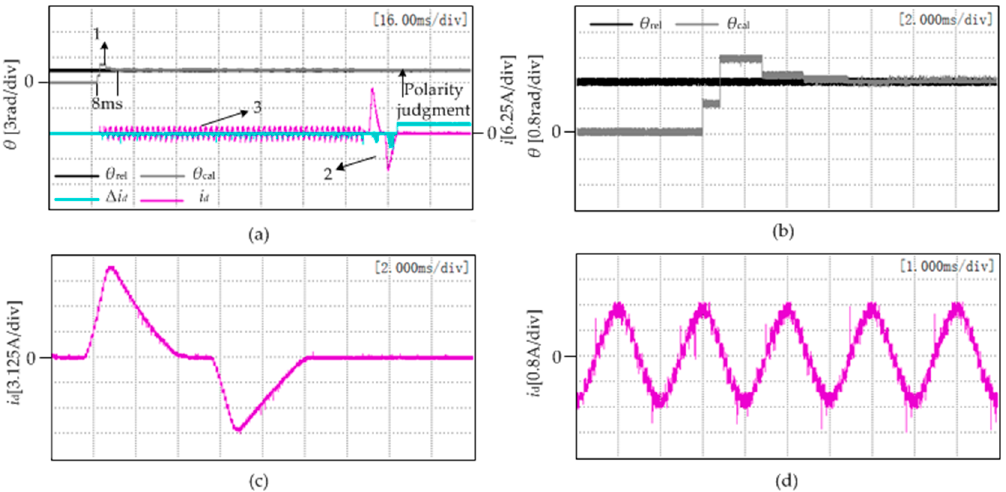
Figure 12. When θ = 88.7 ◦ : ( a ) angle comparison and d-axis current experimental waveforms; ( b ) amplified waveform of 1 area from Figure 12a; ( c ) amplified waveform of 2 area from Figure 12a; ( d ) amplified waveform of 3 area from Figure